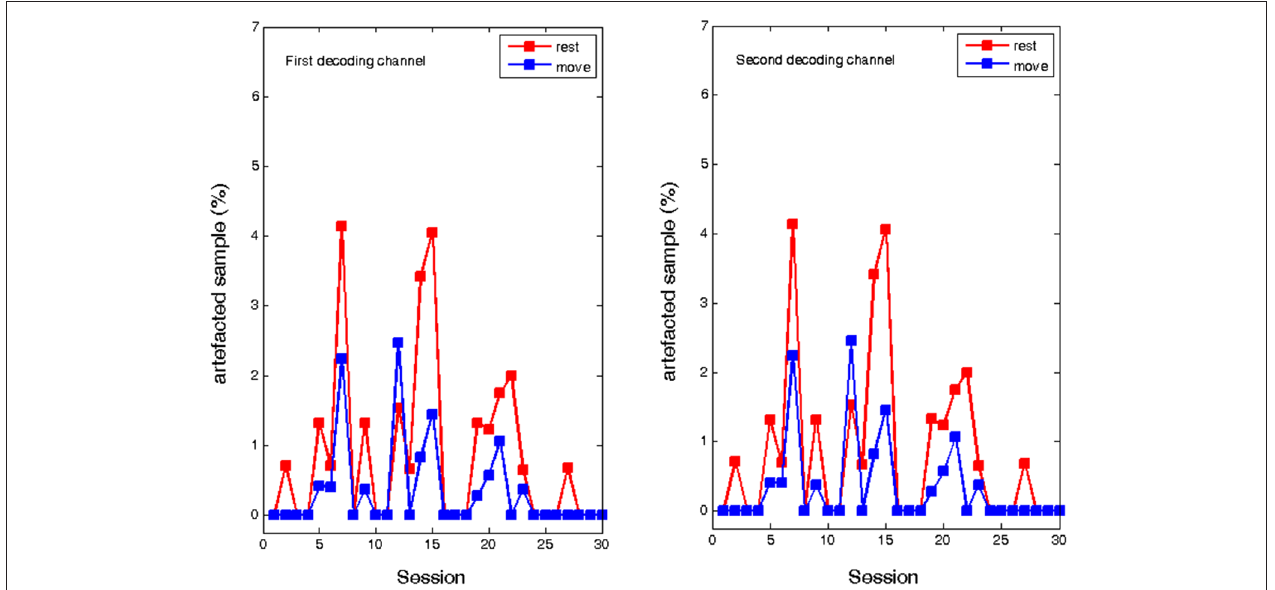
FIGURE 5 | Percentage of artifacted samples during the rest and move condition of the ECoG recordings for two epidural feedback electrodes in the course of thirty sessions .